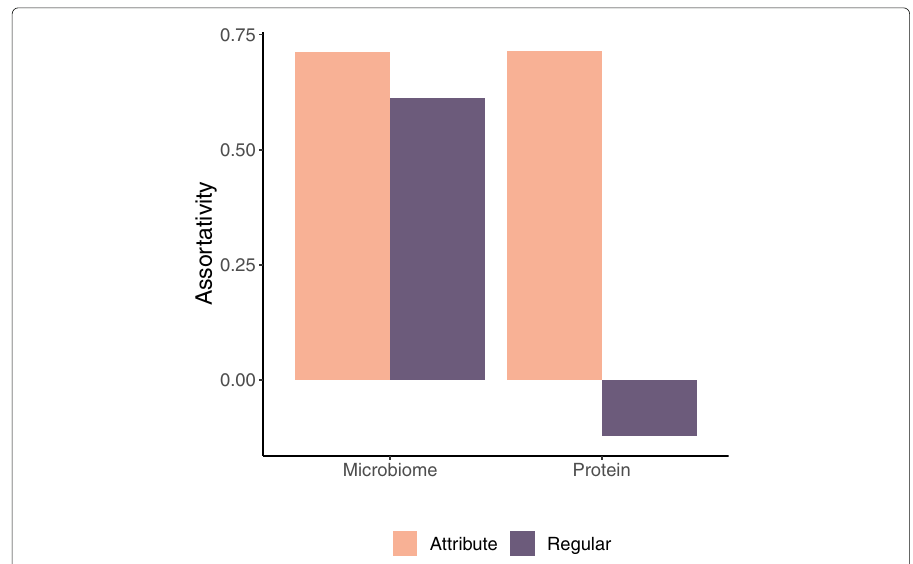
Fig. 11 Assortativity for class and attributed stochastic block models. We computed assortativity coefficients for both the microbiome subject similarity and protein-protein interaction networks. The node-to-community assignments under the regular SBM (purple) and attributed SBM (orange) were used to define node labels when computing assortativity. In both datasets, the use of the attributed SBM lead to higher assortativity